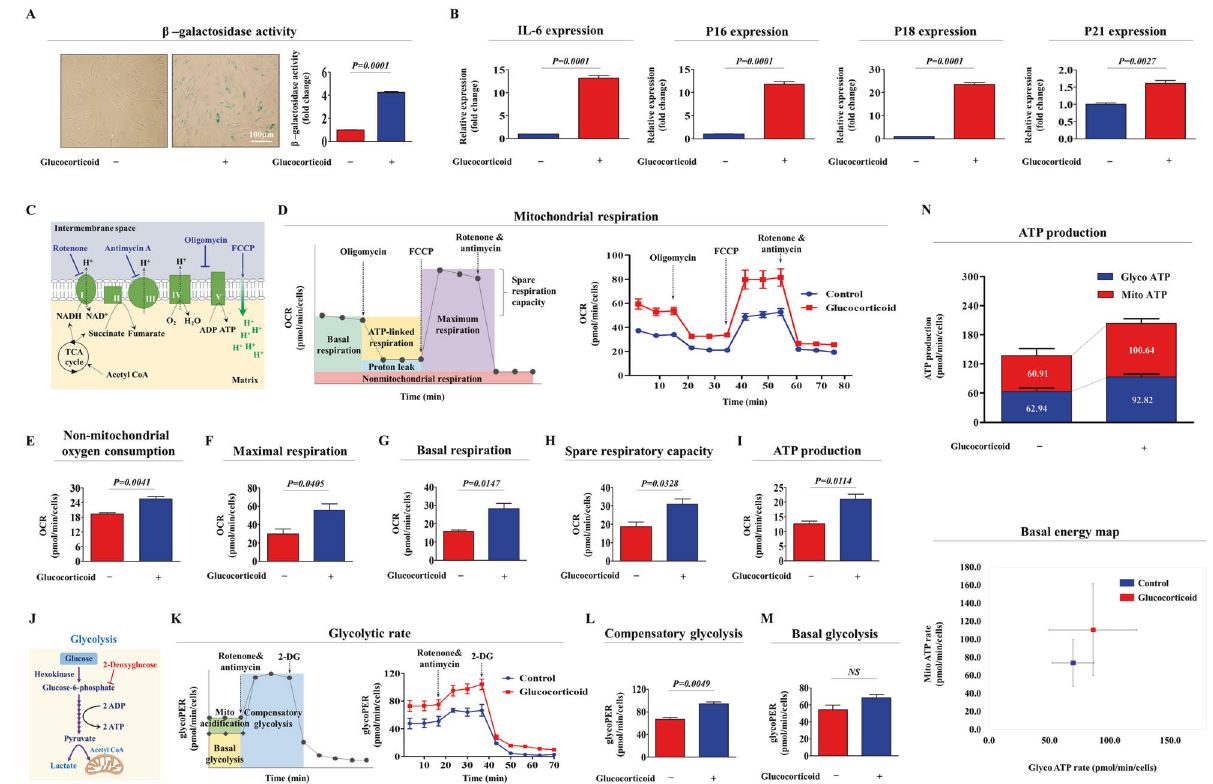
Fig. 2 Glucocorticoid exposure signi fi cantly increases senescence-associated phenotypes and elevates various metabolic activities in endometrial stem cells. The effects of glucocorticoids on stem cell aging in vitro were investigated by evaluating the enzymatic activities of senescence-associated β -galactosidase (SA- β -Gal) ( A ). The effects of glucocorticoids on the expression levels of the senescence-related markers IL-6, p16, p18, and p21 were evaluated by real-time PCR ( B ). To investigate the effect of glucocorticoid treatment on metabolic activity in endometrial stem cells, mitochondrial oxidative phosphorylation and cytosolic glycolysis were assessed with or without glucocorticoid treatment ( C ). Metabolic pro fi les of endometrial stem cells in response to glucocorticoid (100 nM) treatment for 72 h were analyzed by measuring the consecutive oxygen consumption rate (OCR) at multiple time steps using a Seahorse XF analyzer. The ATP synthase inhibitor oligomycin (a complex V inhibitor) was used to block mitochondrial respiration. FCCP (an oxidative phosphorylation uncoupler) was added next to disrupt the mitochondrial membrane potential ( Δψ m). Antimycin A (an inhibitor of complex III of the mitochondrial respiratory chain) and rotenone (an inhibitor of complex I of the mitochondrial respiratory chain) were used to treat cells to completely inhibit mitochondrial oxidative phosphorylation. Mitochondrial respiration rates of endometrial stem cells were largely enhanced in response to glucocorticoid exposure ( D ). Glucocorticoid treatment markedly reduced the nonmitochondrial oxygen consumption rates ( E ), maximal respiration ( F ), basal respiration ( G ), and spare respiratory capacity ( H ) in endometrial stem cells. Overall, ATP synthesis from endometrial stem cells was clearly increased by glucocorticoid treatment ( I ). A schematic diagram of real-time measurements of the glycolytic rate in endometrial stem cells using a Seahorse XF analyzer is shown ( J ). The Seahorse XF glycolytic rate assay uses both OCR and ECAR (extracellular acidi fi cation rate) measurements to determine the real-time glycolytic proton ef fl ux rate (glycoPER) of living cells that were cultured in glucose-free media and then subjected to sequential treatment with rotenone, antimycin A, and glucose competitor 2-deoxyglucose (2-DG, a glycolysis inhibitor) in the presence or absence of glucocorticoids ( K ). Compensatory glycolysis is the rate of glycolytic capacity in living cells following the suppression of oxidative phosphorylation and the increase in compensatory energy synthesis through the use of glycolysis to meet changes in energy requirements ( L ). The percentage (%) of PER from glycolytic capacity reveals the contribution of glycolytic activity to total ECAR ( M ). The measured ECAR and OCR values were normalized relative to the total amount of protein per well. The ATP production rates from both glycolytic and mitochondrial pathways were simultaneously measured and quanti fi ed in real time using a Seahorse real-time ATP rate assay kit ( N ). All experiments were performed in triplicates, and the data has been presented as mean ± standard deviation (SD). P -value under 0.05 was presented in fi inhibitory effects of glucocorticoids is shown in Fig. 3A. The inhibitory effects of glucocorticoids on multiple bene fi cial Importantly, the glucocorticoid-induced inhibitory effect on self- functions of endometrial stem cells are mediated through renewal capacity was markedly abolished by GR depletion (Fig. glucocorticoid receptors (GRs) 3B). To further investigate whether GR-related signaling integrity In other cell types (non-stem cells), the effects of glucocorticoids was associated with self-renewal capacity, we assessed the are mediated through glucocorticoid receptors (GRs), which expression correlation across multiple genes and their signaling belong to the nuclear receptor superfamily; these group includes networks using ingenuity pathway analysis (IPA). Positive regula- receptors for estrogen, mineralocorticoids, retinoic acid, thyroid tors of GR [CDKN2A (Z-score = − 5.664, p -value = 9.90E-01) and hormones, and vitamin D [11]. Therefore, to investigate whether glucocorticoids exert their effects through receptor activation in with growth inhibition, were suppressed in highly proliferative endometrial stem cells, GR was knocked down by stable cells (Fig. 3C). In addition, glucocorticoid-induced inhibitory effects transfection with an shRNA speci fi cally targeting GR (Supplemen- on migratory capacity (Fig. 3D) and MMP-2/9 expression (Fig. 3E) tary. Fig. 2A, B). A schematic representation of the main hypothesis were signi fi cantly attenuated by GR depletion. We also found that about the roles of GR as a functional receptor that mediates the